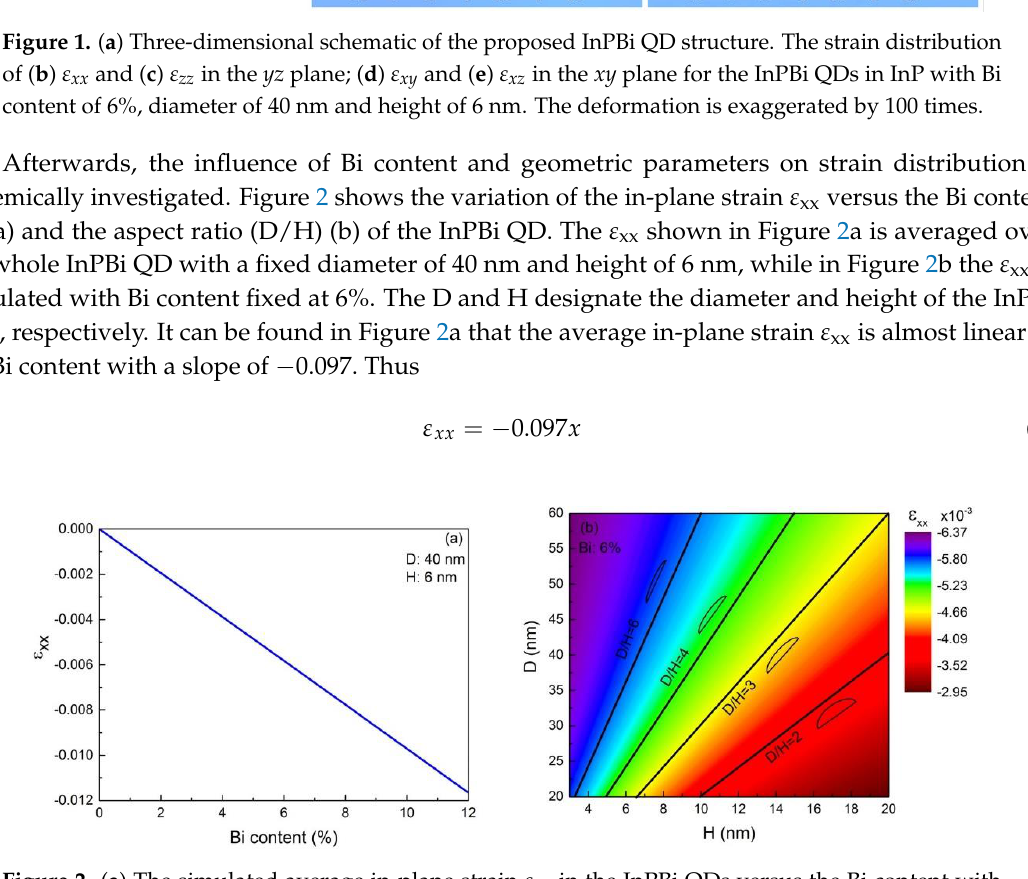
Figure 2. ( a ) The simulated average in-plane strain ε xx in the InPBi QDs versus the Bi content with fixed diameter and height of the QDs of 40 nm and 6 nm, respectively; ( b ) contour map of the average ε xx versus the diameter and height of the InPBi QDs with the Bi content of 6%. The black lines represent the aspect ratio of 2, 3, 4 and 6, respectively, with the diagrammatic sketch of the shape of the QD next to each line.